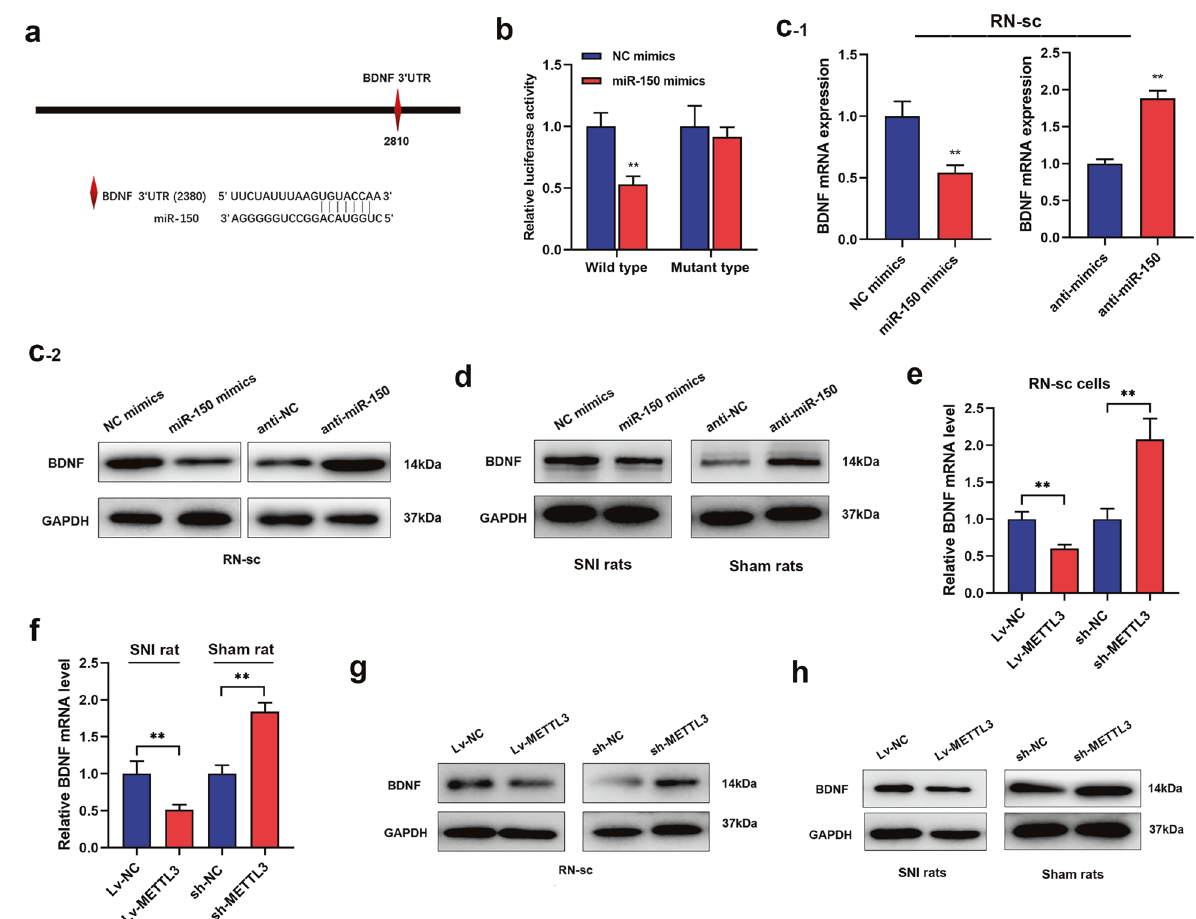
inhibition (repeated in triplicates). ** P < 0.01 in comparison with NC group. c BDNF mRNA ( c -1 ) and protein ( c -2 ) expressions were detected upon overexpression or silence of miR-150 ( N = 3). ** P < 0.01 in comparison with control group. d BDNF protein level in spinal cord tissues was evaluated via western blot upon overexpression of miR-150 in SNI rats and knockdown of miR-150 in sham rats. BDNF protein was negatively regulated in the above rat models. e , f BDNF mRNA was determined in RN-sc cells ( e ) and spinal cord tissues ( f ) from sham rats or SNI ones when METTL3 was dysregulated. BDNF transcript was negatively regulated by METTL3 expression (repeated in triplicates). ** P < 0.01. g , h Effects of METTL3 on BDNF protein expression were evaluated via western blot analysis in RN-sc cells ( g ) and spinal cord tissues of SNI rats or sham ones ( h ). The experiment was repeated three times with similar